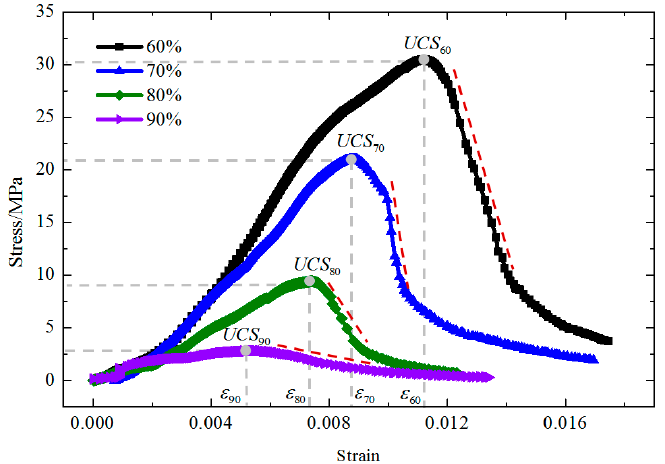
Figure 7. Typical stress-strain curves for cylindrical specimens of welded bimrocks.